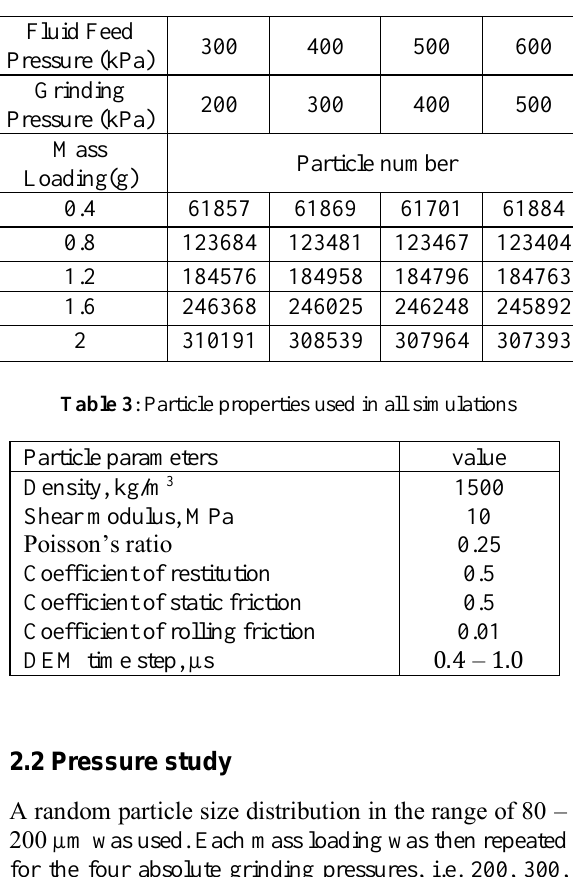
Table 2 : Pressure study parameters